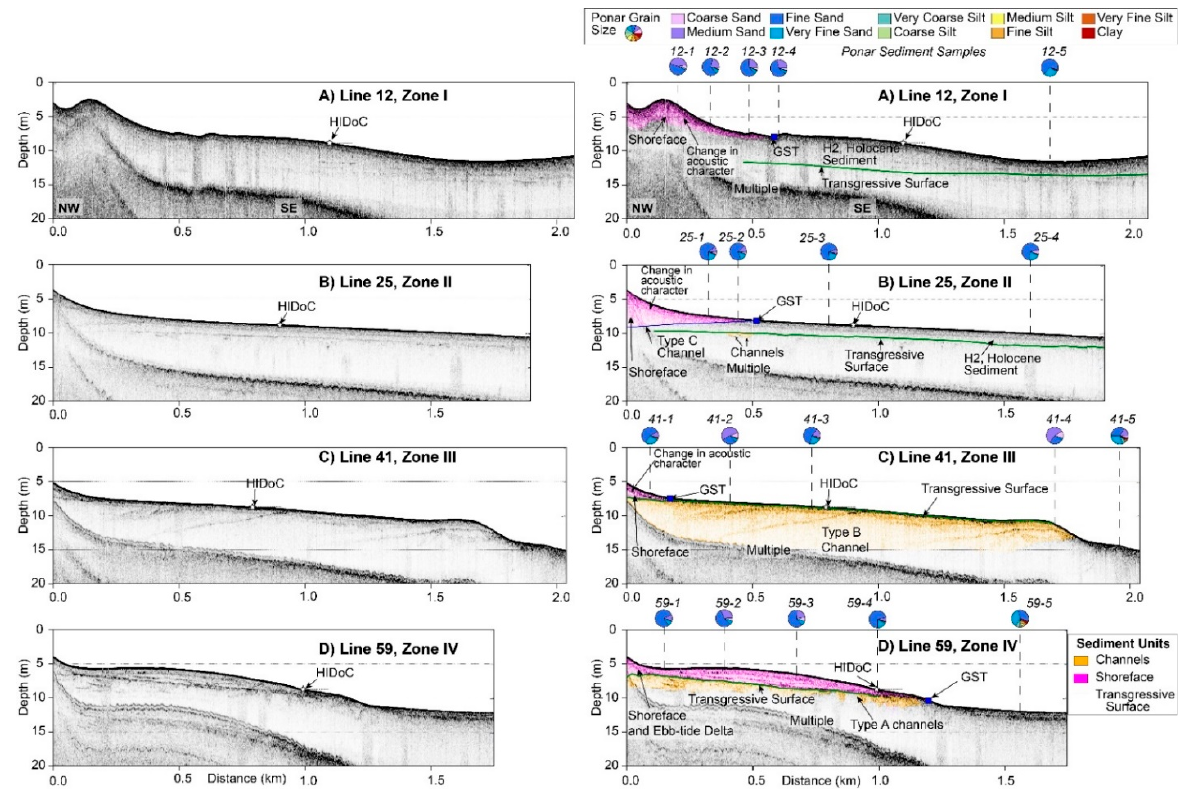
Figure 8. Uninterpreted (left) and interpreted (right) dip profiles from each of the four geomorphic zones highlight variable shoreface morphology across the peninsula. ( A ) Line 12, ( B ) Line 25, ( C ) Line 41, and ( D ) Line 59. Dashed black lines show the location of surficial sediment grabs; grain size composition is shown by colored wedges; and italic numbers above grain size composition are sample names referenced in Sections 4.2.2 and 4.2.3. GST = Geologic Shoreface Toe. HIDoC = Hallermeier (1981) inner depth of closure. Profile locations are shown in Figure 1.